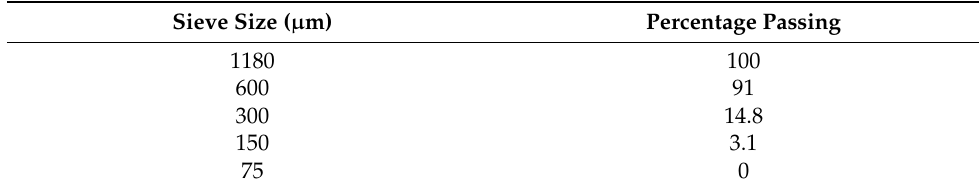
Table 4. Natural fine sand aggregate